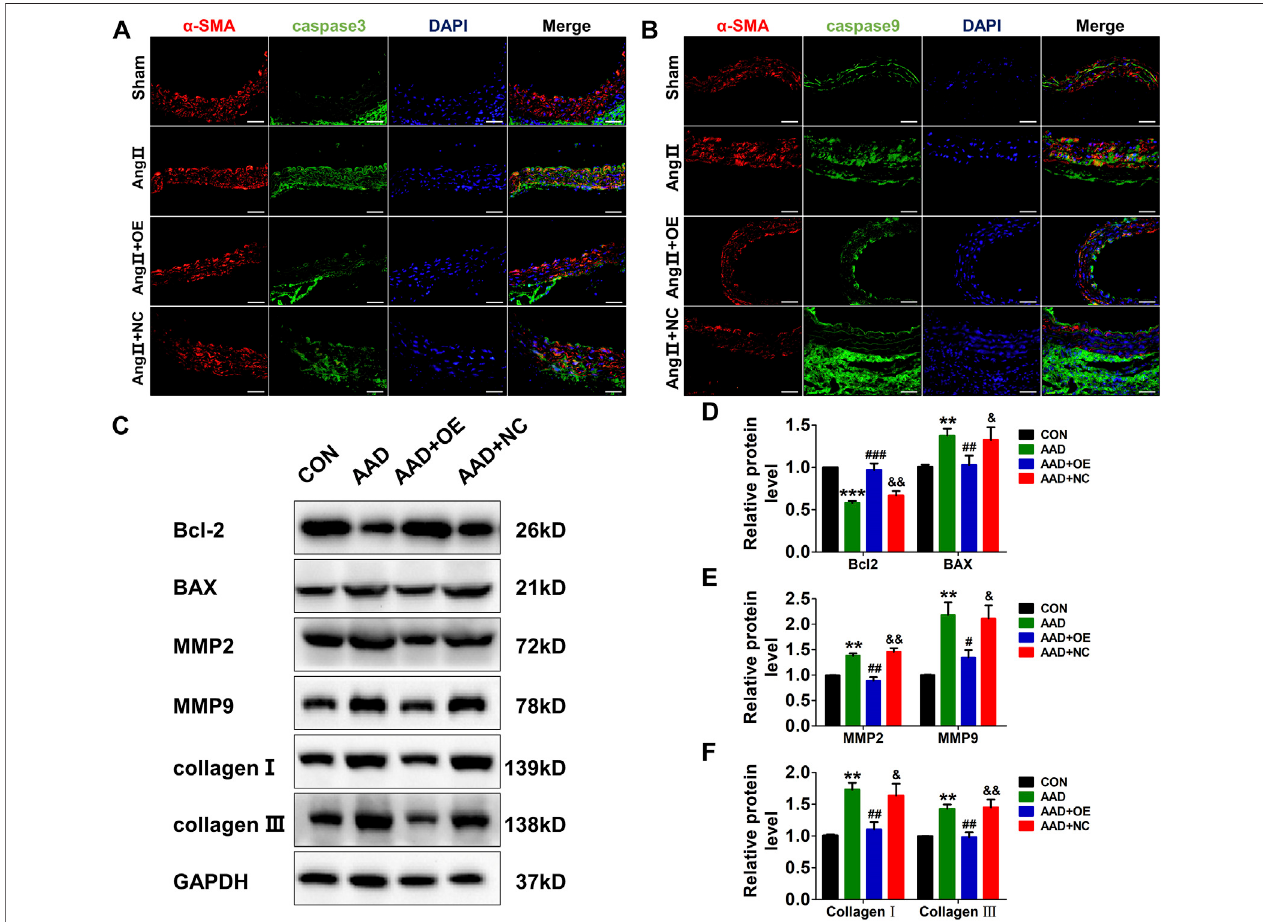
FIGURE6 | Overexpression oflnc-C2orf63-4-1 inhibits Ang II-induced vascular apoptosis, fi brosis, and MMP-2/9 activity in ApoE − / − mice. (A) Immuno fl uorescent staining of α -SMA (red) and caspase-3 (green) of the aorta in all groups. ( n (cid:1) 4/per group) (B) Immuno fl uorescent staining of α -SMA (red) and caspase-9 (green) of the aortainallgroups.( n (cid:1) 4/pergroup) (C – F) RepresentativeWesternblottingimagesandquanti fi cationofBcl-2,Bax,MMP-2,MMP-9,typeIcollagen,andtypeIIIcollagen in aorta tissue of all groups ( n (cid:1) 6/per group). GAPDH was used for internal normalization. Data of (D – F) were compared by analysis-of-variance (ANOVA) with Bonferroni ’ s post-test. ** p < 0.01, *** p < 0.001 vs. control group, # p < 0.05, ## p < 0.01, ### p < 0.001 vs. AAD group, & p < 0.05, && p < 0.01 vs. AAD + OE group. Data were all expressed as mean ±